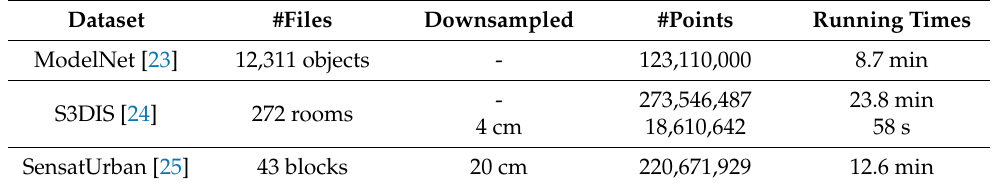
Table 8. Running times of the proposed implicit feature encoding. The SuperPoint Graph [19] and RandLA-Net [20] backbones use voxel-based downsampling as a pre-processing step, so we calculated implicit features on the downsampled point clouds. As the PointNet backbone [7] does not follow such a procedure, we calculated implicit features on the original input point clouds. #Files and #Points denote the number of files and points, respectively.